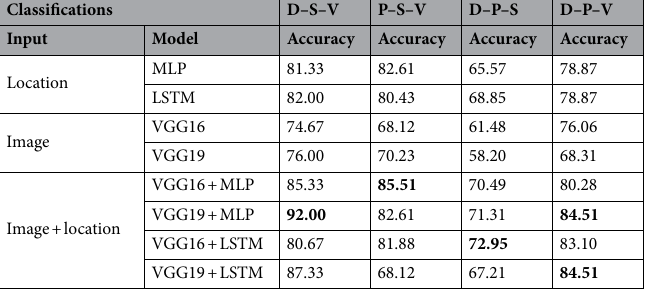
Table 8. Four three-wound-class classifications on AZH dataset. The bold represents the highest results/ accuracy achieved for each experiment.